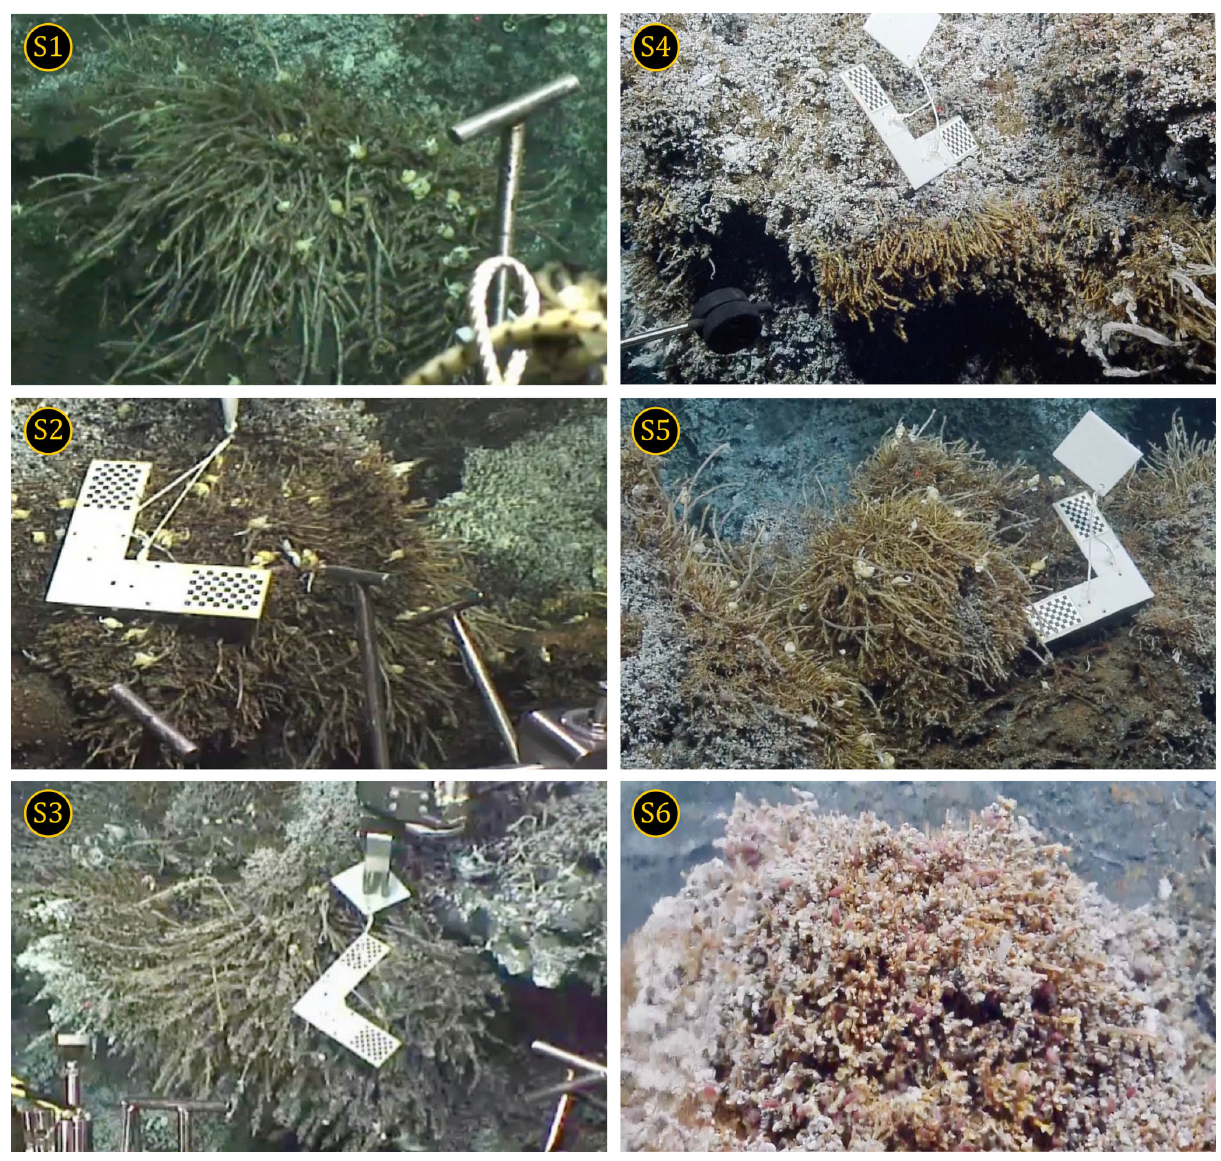
Figure 2. Hydrothermal samples collected on the Grotto edifice (Main Endeavour Field, Juan de Fuca Ridge) during Ocean Networks Canada oceanographic cruises Wiring the Abyss 2015 and